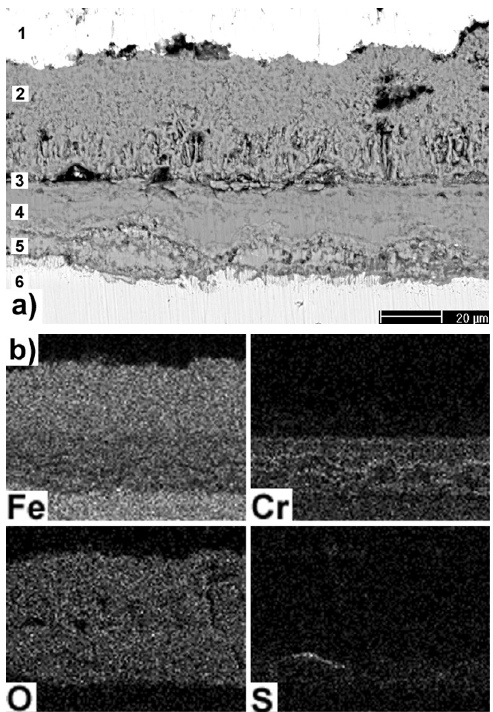
Figure 13. Cross-section of uncoated P91 after 336 hours at 883 K in N 2 (cid:3) 1000 ppmv HCl (cid:3) 100 ppmv SO 10 % H 2 O (cid:3) 8:4 % O 2 . a) BSE-image. 1) Nickel coating. 2) Fe 2 O 3 . 3) Original surface. 4) Cr-rich layer. 5)